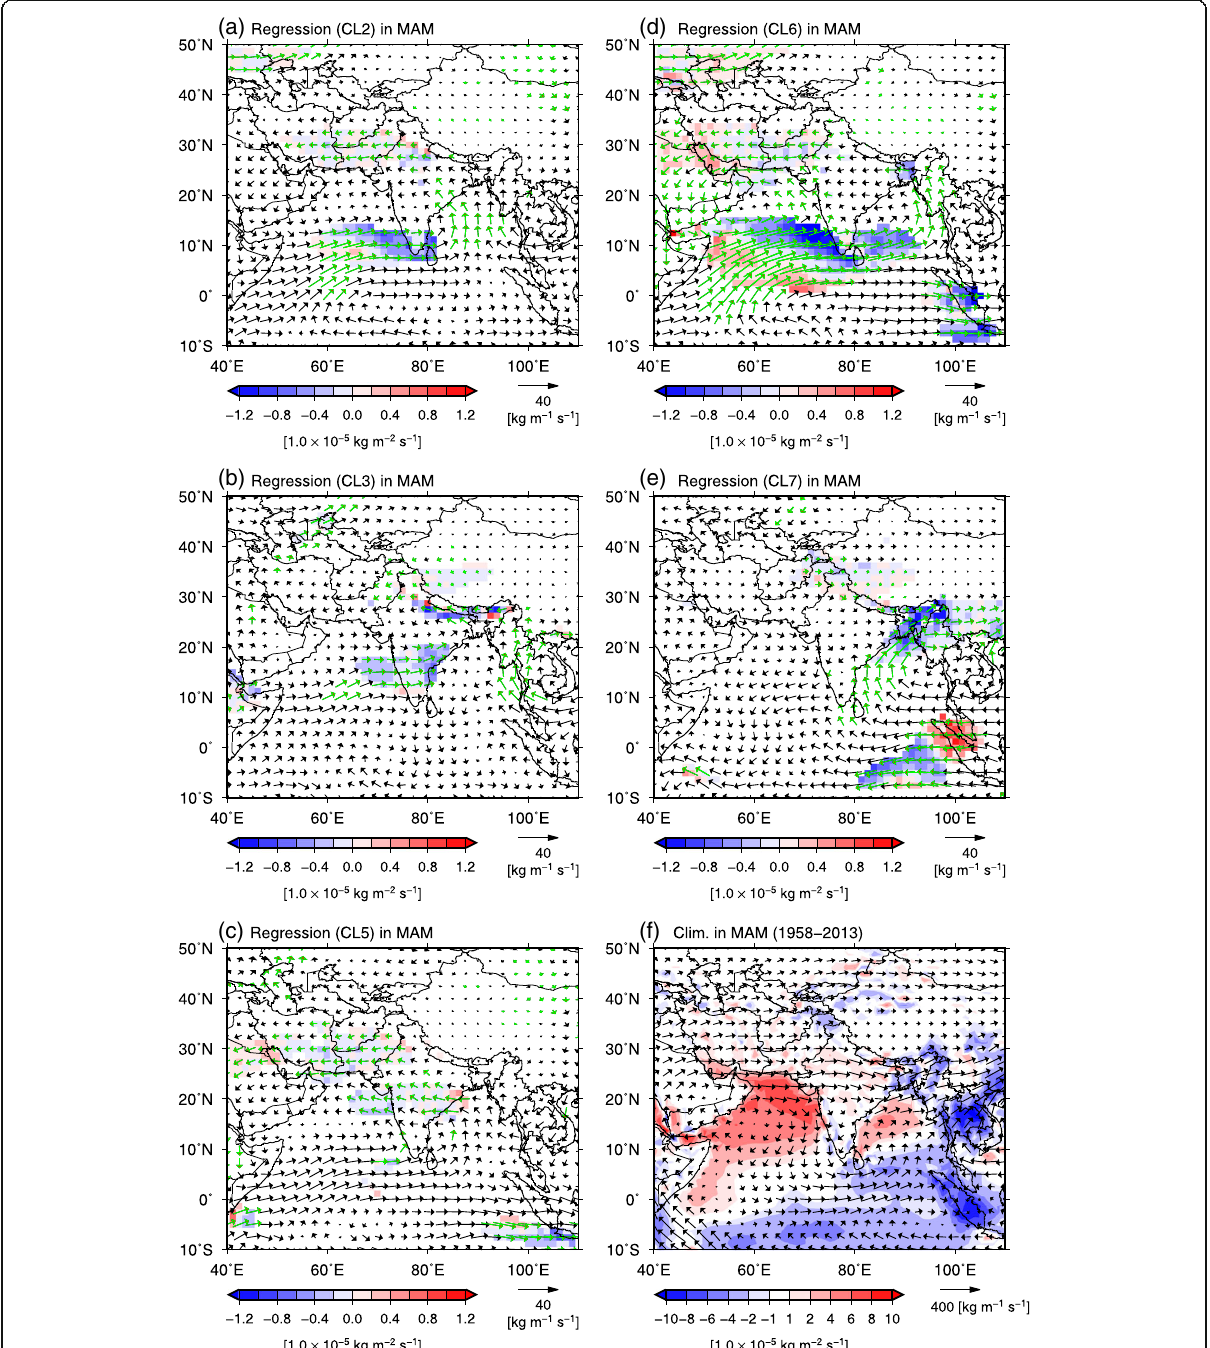
Fig. 12 Same as Fig. 8 but for the pre-monsoon season (MAM) The regression coefficient (objective variable is precipitation) between interannual variation of rainfall and water vapor flux (kg m − 1 s − 1 ) (vector) and its divergence (× 10 − 5 kg m − 1 s − 1 ) (shaded) as the regression coefficient (objective variable is precipitation) for each cluster ( a ) – ( e ), and the distribution of climatological averaged values for 1958 – 2013 for the water vapor flux and divergence ( f